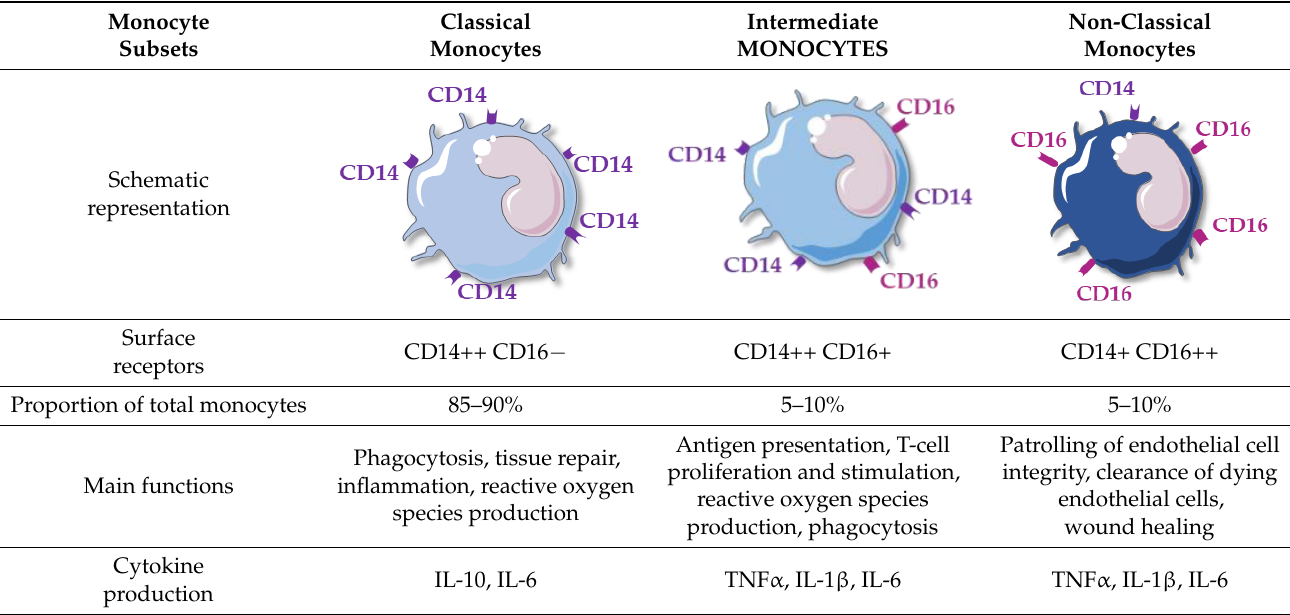
Table 1. Main characteristics of human circulating monocyte subsets. Abbreviations: cluster differen-